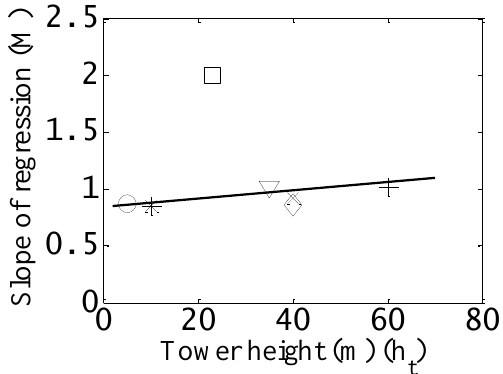
Figure 4. Scatter plot showing the slope of regression ( M ) between the observed and estimated λE as a function of the correspond- Figure 4. Scatterplot showing the slope of regression (M) between the observed and estimated λE as a function of the corresponding λE measurement height (tower height, h t ) ing λE measurement height (tower height, h t ) for different biome for different biome classes. The tower heights of similar biomes are averaged. The solid classes. The tower heights of similar biomes are averaged. The solid line is the best fit relationship (M = 0.003h t + 0.84, R 2 = 0.46) after removing the SAV line is the best-fit relationship ( M = 0 . 003 h t + 0 . 84, R 2 = 0 . 46) biome type. This shows M approaches unity with h t . after removing the SAV biome type. This shows that M approaches unity with h t